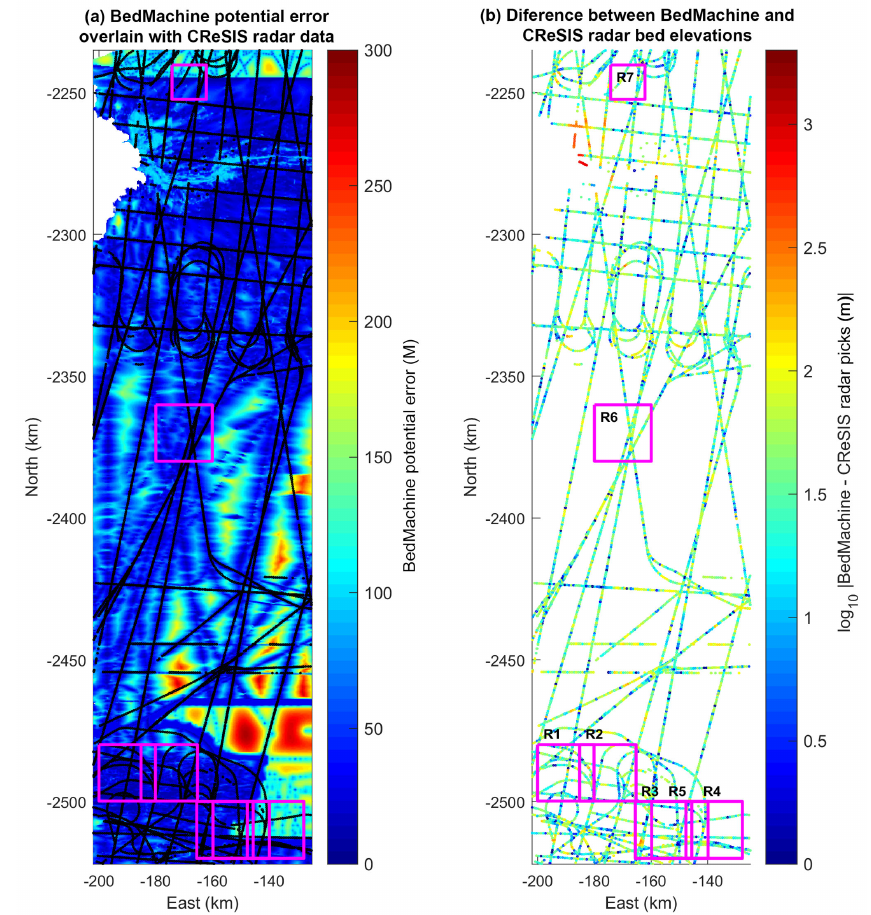
Figure 2. (a) BedMachine v3 potential bed elevation error overlain by CReSIS radar bed elevation picks (Morlighem et al., 2017a, b; CReSIS, 2016). BedMachine includes radar data from other sources not shown here and is also constrained with mass conservation modeling over most of the region shown. BedMachine error generally decreases where elevations are better constrained by radar data. Our study regions (magenta) encompass a broad range of bed DEM quality (Fig. 1a, Table 1). (b) Difference between bed elevations from BedMachine and CReSIS radar picks (only including radar picks marked as good quality). In many regions there is appreciable scatter in radar elevation picks and significant error in the derived bed DEM; we examine the impact this uncertainty has on ice surface